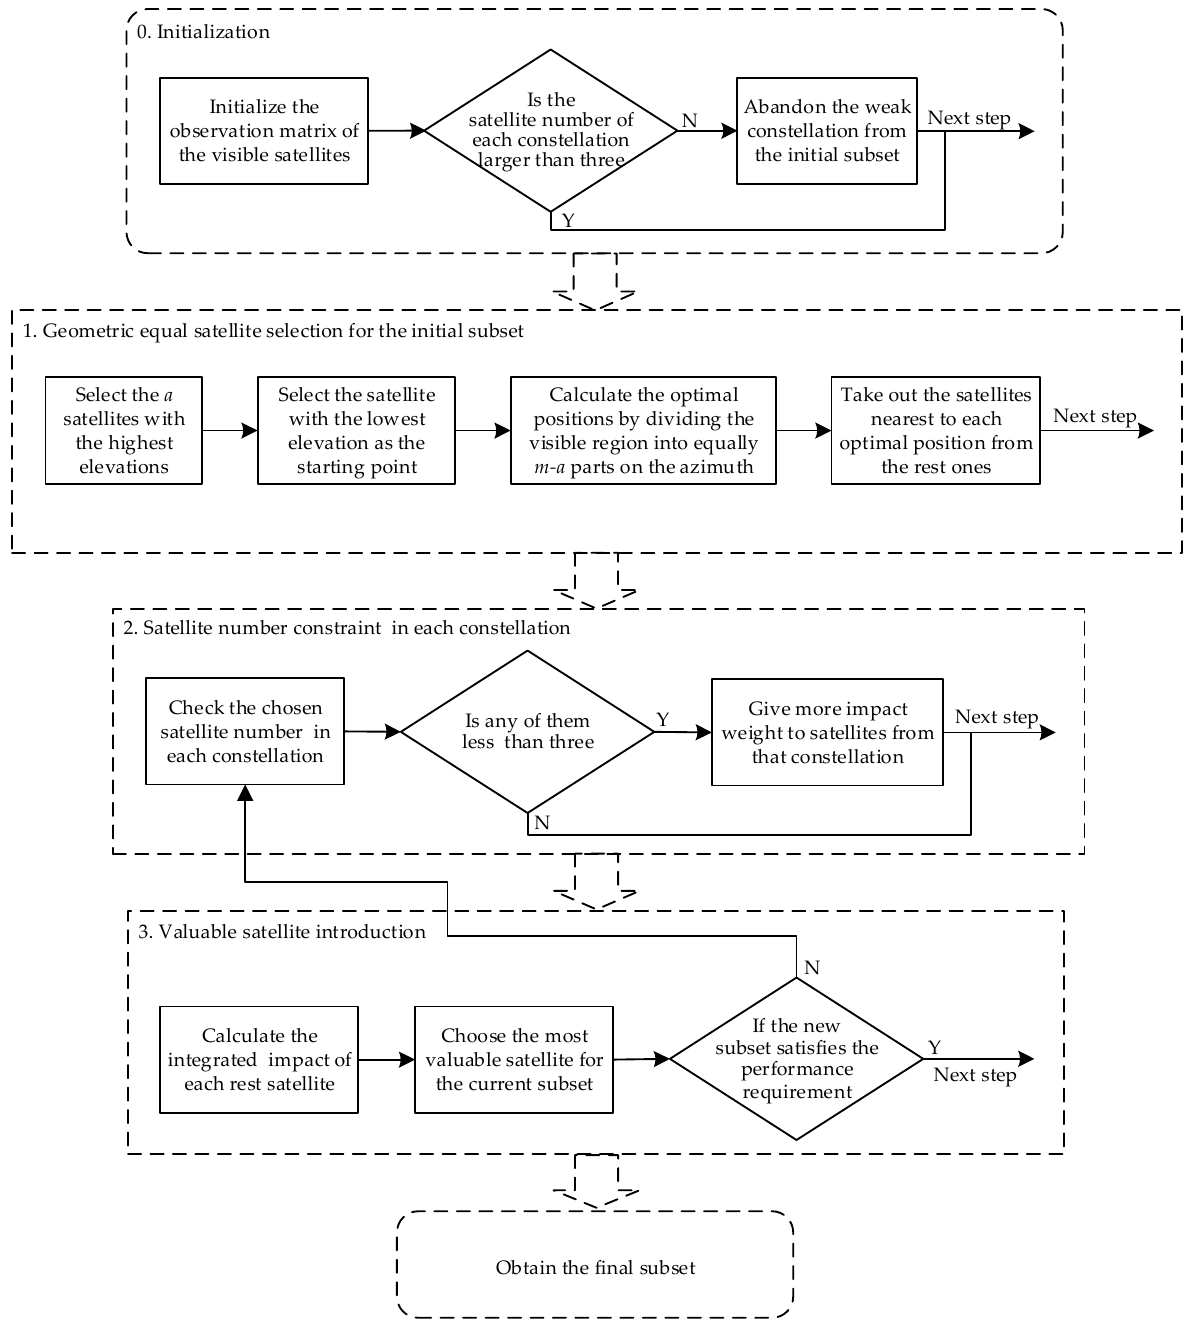
Figure 4. Schematic overview of the PRDFSS algorithm.